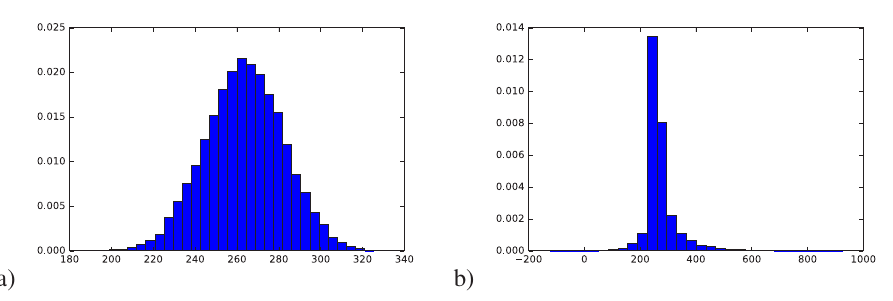
Figure 6: Results of PCE reconstructed distribution, a) n = 10, m = 1; b) n = 10, m =